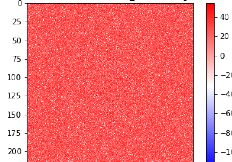
Figure 3. For atk = EA ( left pair) and atk = BIM ( right pair), representation of | DFT ( D atk A 4 ) | (magn (diff), first image) and | DFT ( D atk 5 the red channel.